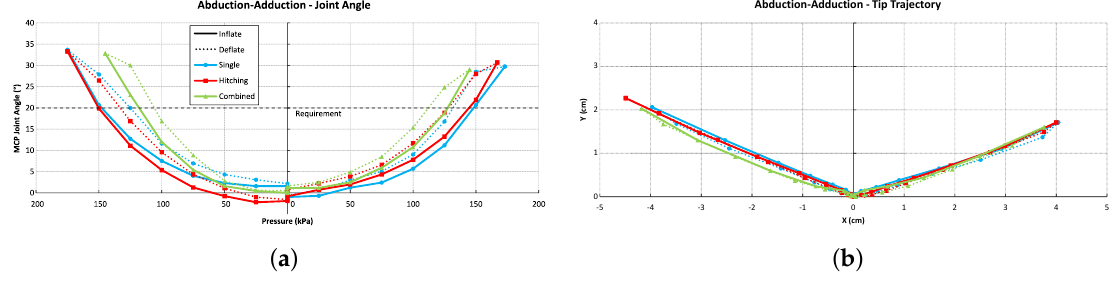
Figure 8. Motion capture measurement results for MCP joint abduction-adduction to the left and right, showing ( a ) the joint angle and ( b ) fingertip trajectory from above.